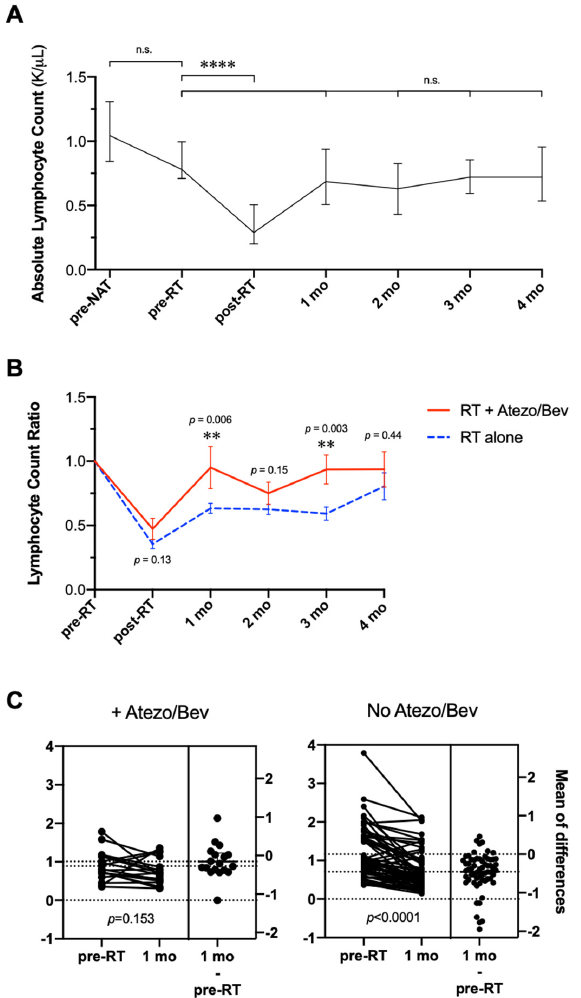
Figure 5. RT with atezolizumab plus bevacizumab is associated with accelerated recovery of lym- phopenia. Depicted are absolute lymphocyte counts ( A ) in patients receiving RT with atezolizumab plus bevacizumab in all sequences, shown as median with IQR. ( B ) Post-RT to pre-RT ratios of the ALC up to 4 months post-treatment, comparing patients who received RT with atezolizumab plus bevacizumab in all sequences vs. RT without these therapies (mean ± SEM). ( C ) Individual patient ALC differences 1 month post-RT vs. pre-treatment baseline comparing patients who underwent combined modality therapy vs. RT without. Abbreviations: RT = radiation therapy; ALC = absolute lymphocyte counts; mo = month. p -values were derived from parametric Student’s t tests. * p < 0.05, ** p < 0.01, **** p < 0.0001, *** p < 0.001, n.s. = not statistically significant. This cohort was then compared to a previously published cohort from our institution of patients with HCC treated with RT without atezolizumab or bevacizumab [17] in order to examine if the combination of RT and atezolizumab immunotherapy (in the collective sequence) influenced the pace of ALC recovery. Post-RT to pre-RT ratios of the ALC com- puted at various timepoints (Figure 5B) up to 4 months demonstrated an accelerated re- turn to baseline lymphocyte count among patients who received RT with atezolizumab plus bevacizumab vs. RT without these systemic therapies ( p < 0.04 at 1 month, n.s. at 2–4 months).